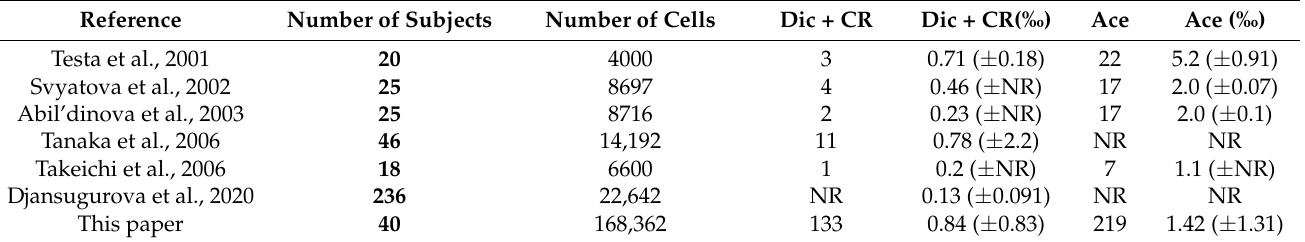
Table 3. Comparison of chromosome aberration frequencies in the Kazakhstan control groups.